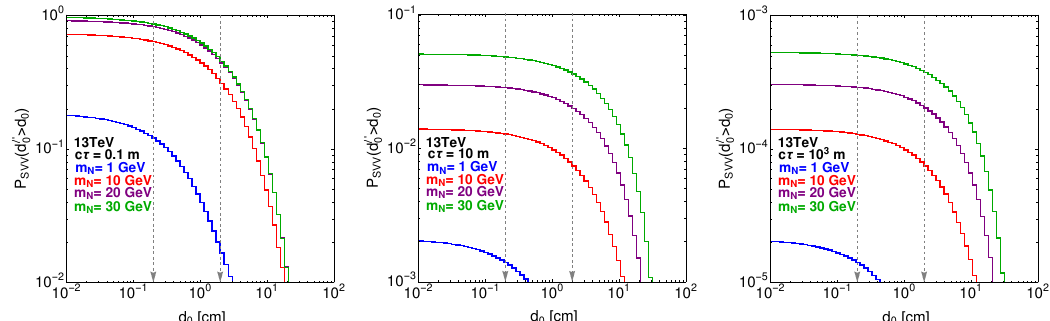
Figure 3 . The survival probability P SVV ( d ‘ 0 > d 0 ) for the lepton ‘ 0 from the sterile neutrino decay 0 N ! ‘ 0 jj , as a function of the minimal d 0 cut. From left to right, the proper lifetime of sterile neutrino c(cid:28) are set as 0 : 1, 10 and 1000 meters, respectively. The two gray dashed arrows show d 0 = 0 : 2 cm and d 0 = 2 cm, which correspond to our benchmark selection